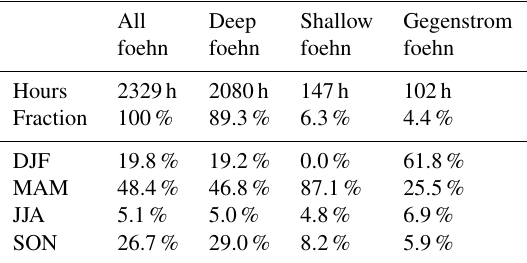
Table 2. Table providing the foehn hours for the deep-foehn sub- types, their relative occurrence frequency and